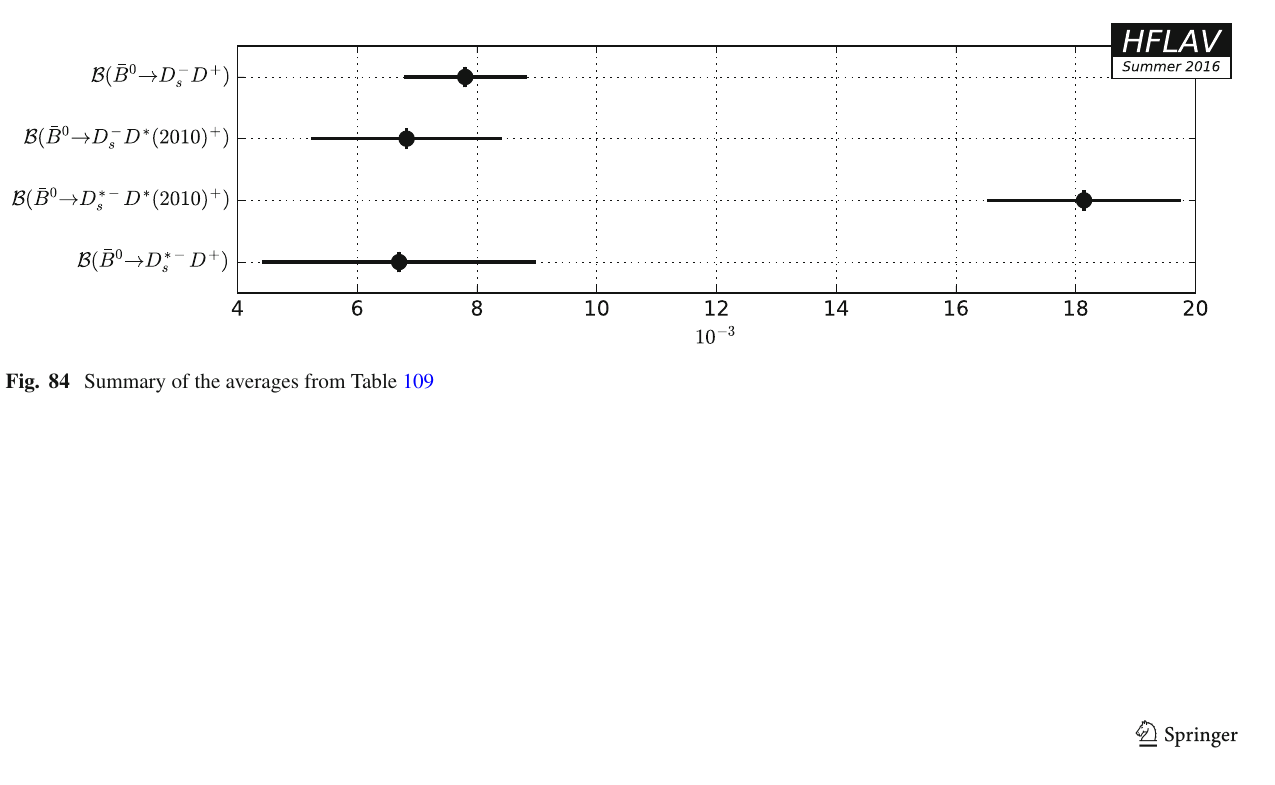
Fig. 83 Summary of the averages from Table 108